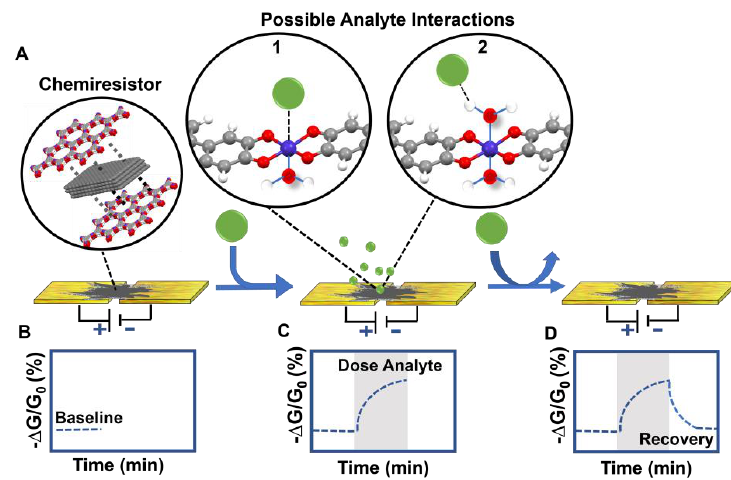
Figure 4. Schematic diagram of a MOF-based chemiresistor and possible analyte interactions. ( A ) A chemiresistive material (i.e., MOF/graphite blend) completes a circuit by bridging two electrodes. ( B ) The initial sensing trace (dashed blue line) shows a baseline (change in normalized conductance over time). ( C ) The chemiresistive device is exposed (grey shading indicates time of analyte dose) to an analyte (green circle) which can interact with the chemiresistive material by coordinating to the metal center (1), hydrogen bonding to the water at the axial position (2) or other binding modes. Perturbation to the charge transport through the nanomaterial leads to a change in conductance coincident with analyte binding. ( D ) In reversible binding modes, exposure to an inert carrier gas displaces the analyte, corresponding to the recovery of conductance back towards the original